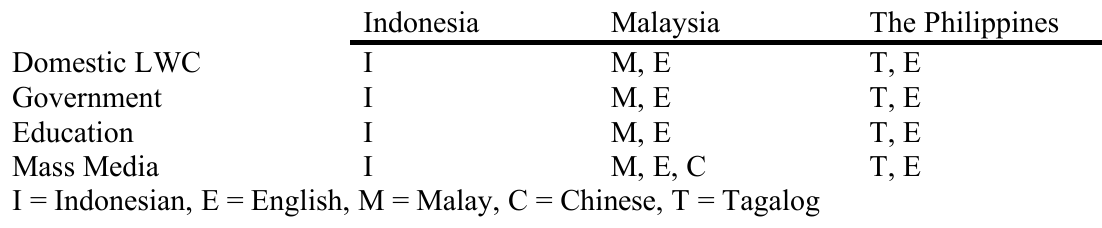
Table 2 Indonesia Malaysia The Philippines Domestic LWC I M, E T, E Government I M, E T, E Education I M, E T, E Mass Media I M, E, C T,